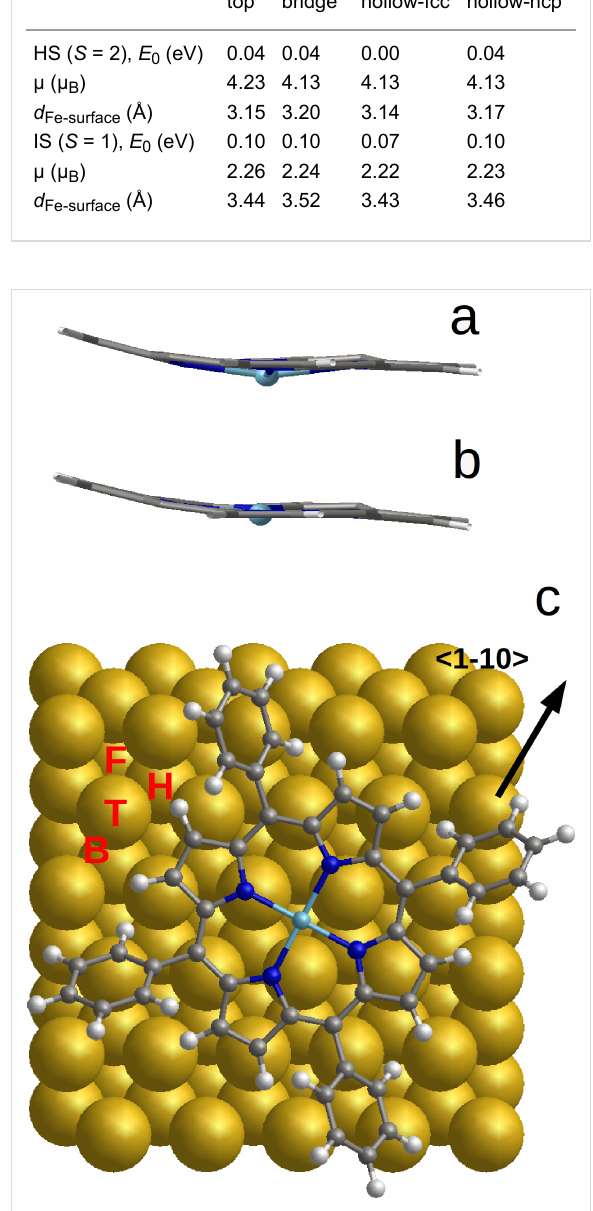
Figure 5: Conformation of the central porphyrin core in a) HS state; b) IS state (phenyl rings were omitted for clarity). In c) example of FeTPP adsorbed on fcc site of Au(111) on which the positions of the top (T), bridge (B), fcc (F) and hcp (H) sites are indicated. The opti- mized molecule is oriented along the <1 − 10>